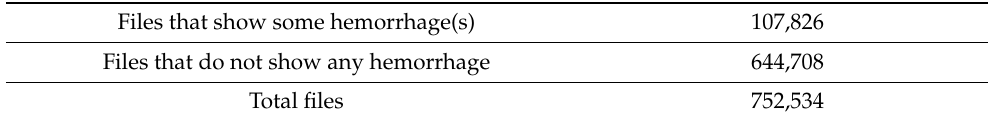
Table 1. The total number of files with and without hemorrhage (s). Files that show some